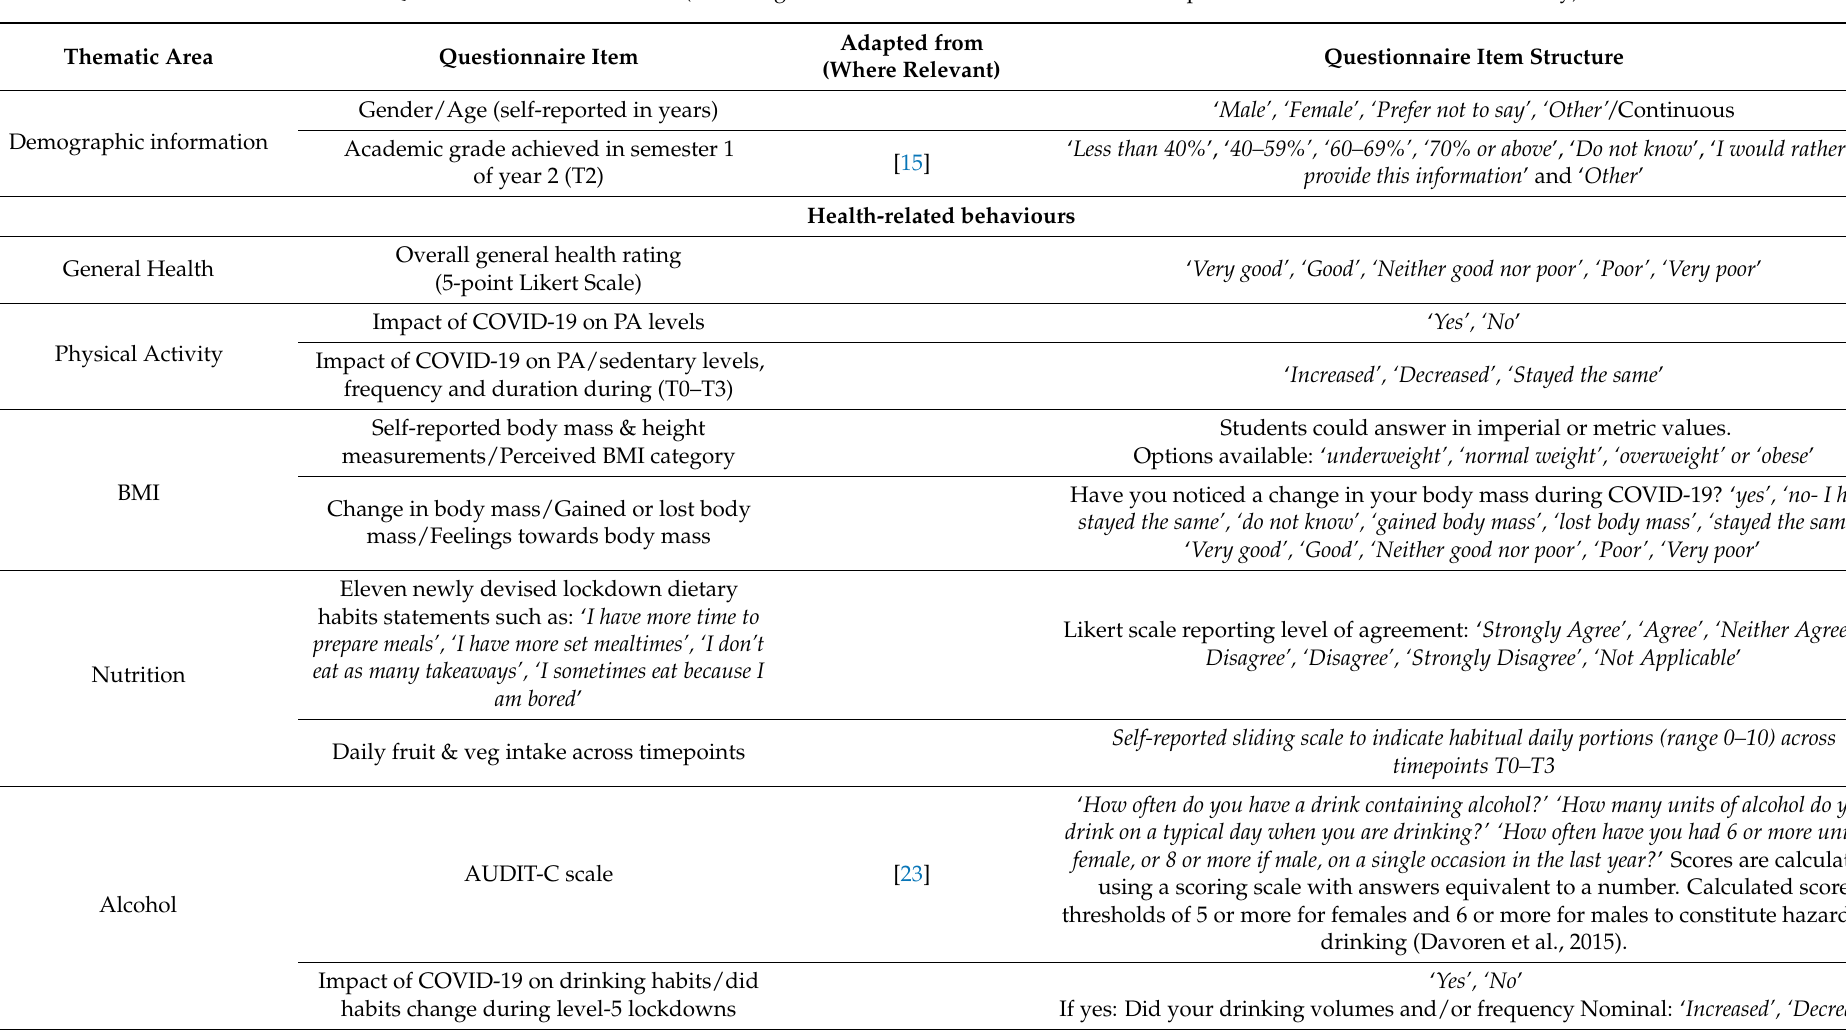
Table 2. Questionnaire thematic areas (including validated scales and refined items from previous research for the current